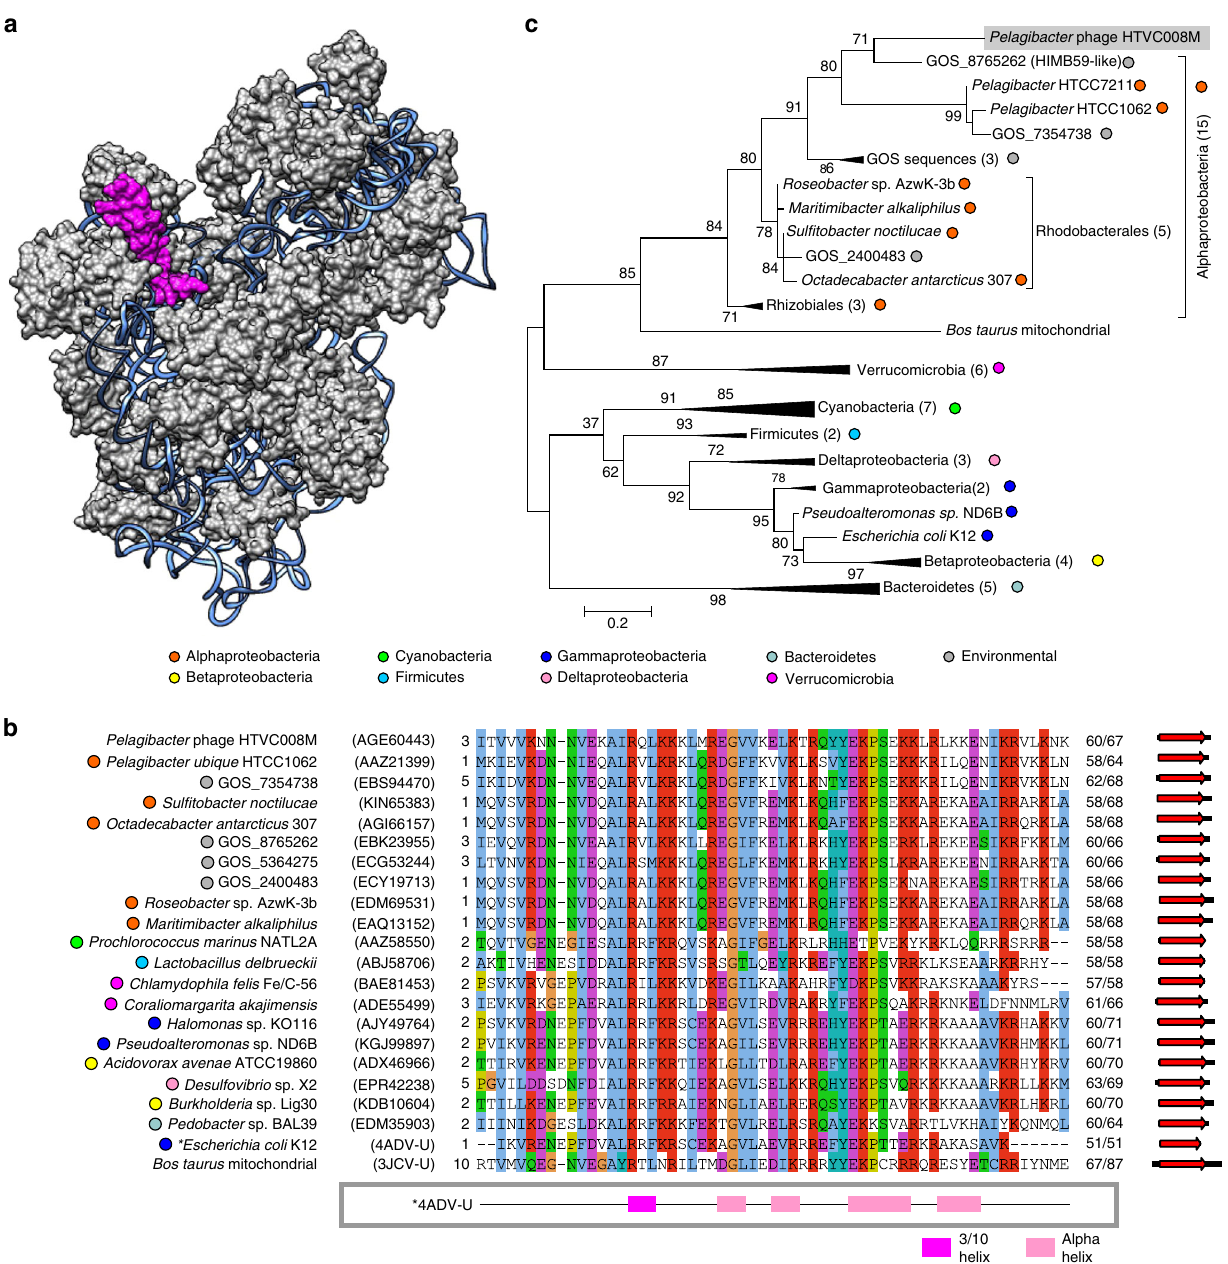
Fig. 1 Virus-encoded ribosomal protein bS21. a Structure of the Escherichia coli 30S ribosomal subunit (PDB id: 4ADV). 16S ribosomal RNA is shown as blue ribbon. bS21 ribosomal protein is highlighted in pink. b Alignment of the ribosomal protein bS21 encoded by pelagiphage HTVC008M with homologs from representatives of distinct bacterial taxa and environmental sequences obtained from the Global Ocean Sampling (GOS) dataset. c Phylogenetic tree of ribosomal protein bS21. Taxonomic af fi liations are represented by colored circles (see panel ( b )